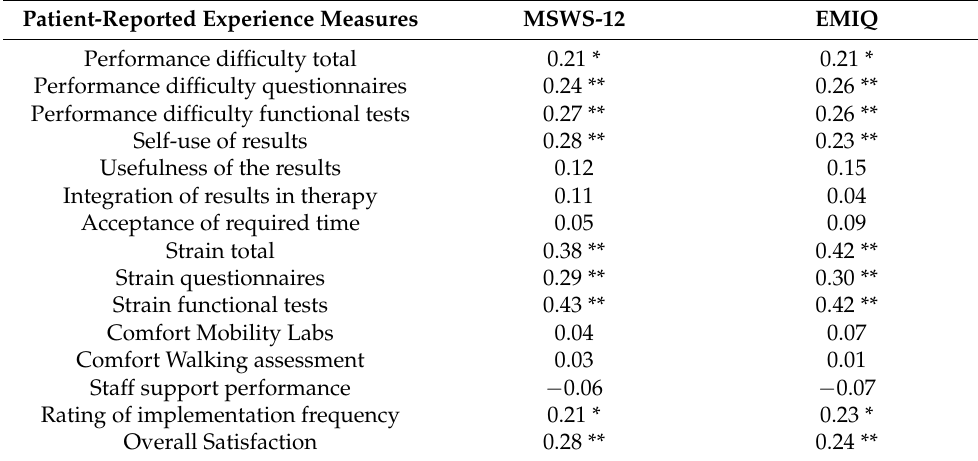
Table 6. Kendall’s Tau-b ( τ ) correlation between patient-reported outcome measures and patient- experienced outcome measures ( N = 105).